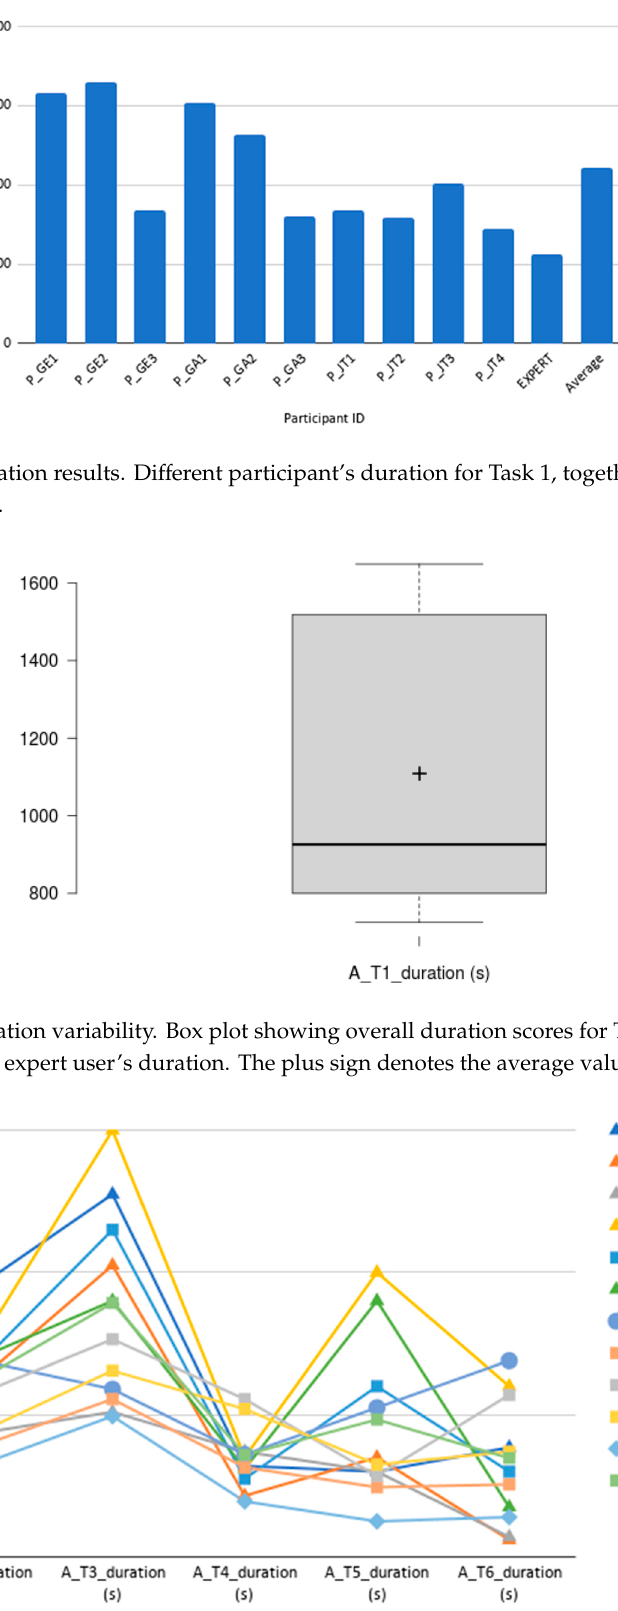
Figure 14. Tasks 2–6 duration results. Different participants’ durations for tasks 2–6, together with the expert’s and average durations.